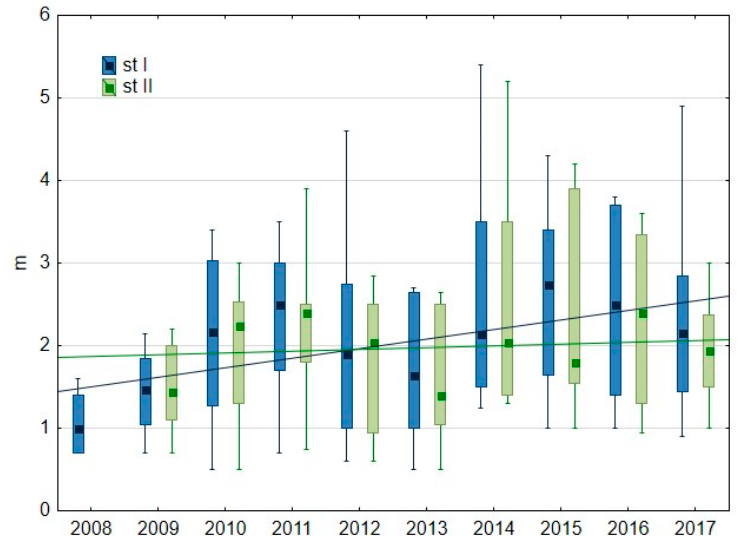
Figure 6. Box plot with min-max of Secchi depth in Lake Durowskie at both stations. The lines indicate trendlines for each station.